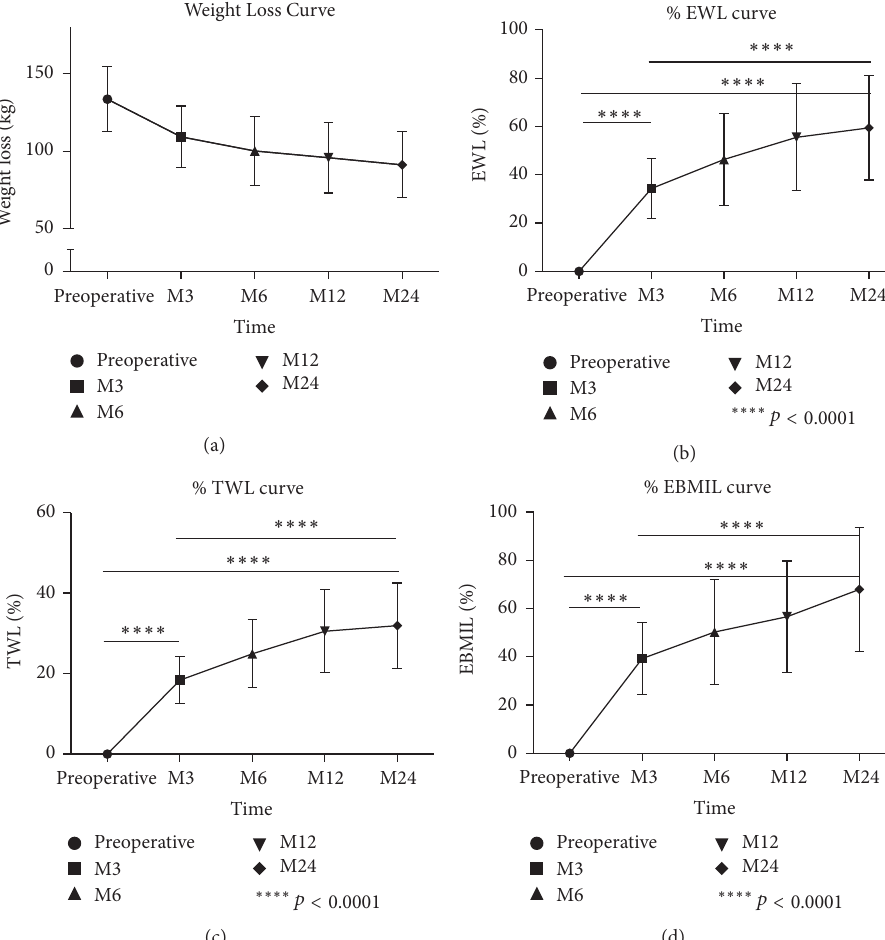
Figure 1: Evolution in weight parameters during 24 months of follow-up. M3: at 3 months; M6: at 6 months; M12: at 12 months; M24: at 24 months. (a) Weight Loss Curve before and after SG: preoperative and at M3, M6, M12, and M24. (b) % EWL curve before and after SG: preoperative and at M3, M6, M12, and M24. (c) % TWL curve before and after SG: preoperative and at M3, M6, M12, and M24. (d) % EBMIL curve before and after SG: preoperative and at M3, M6, M12, and